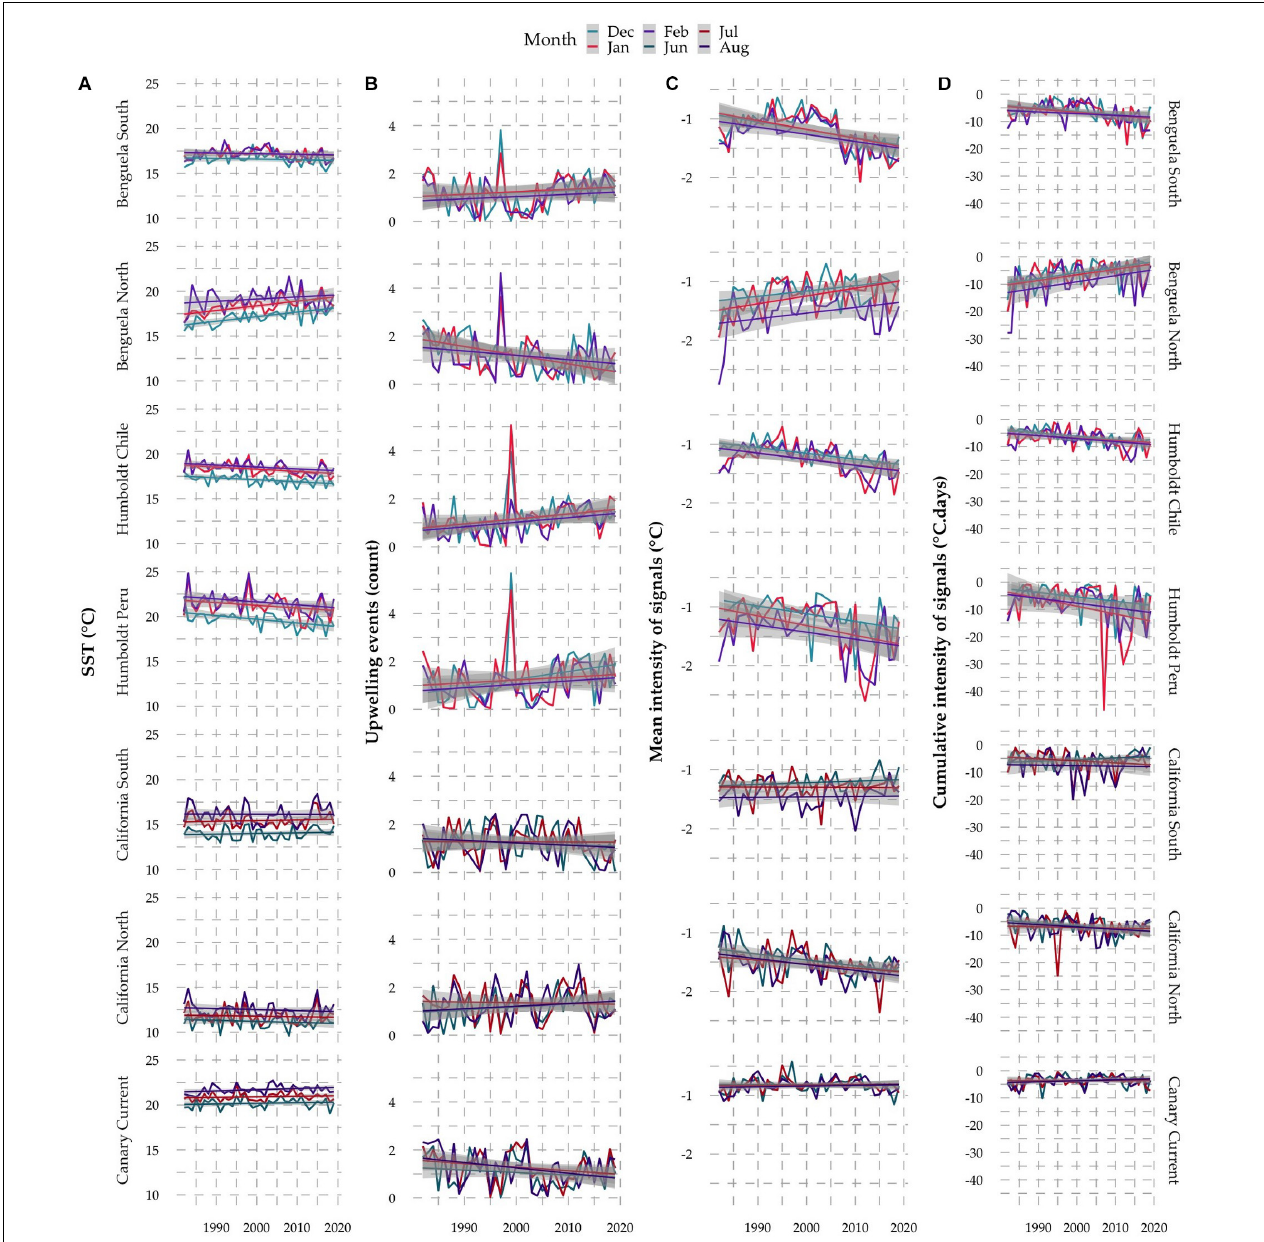
FIGURE 2 | SST trends (A) and the count (B) , mean (C) , and cumulative intensity (D) of upwelling signals during austral (DJF) and boreal (JJA) summer months over a period of 37 years. Where a more negative intensity represent a more intense